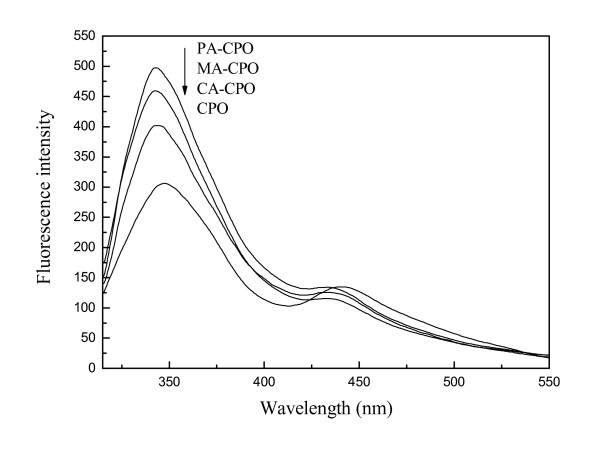
Fluorescence spectra of native and modified CPOs in 10 mM acetate buffer. Excitation wavelength was 295 nm; Enzyme concentration was 7.5 μM.